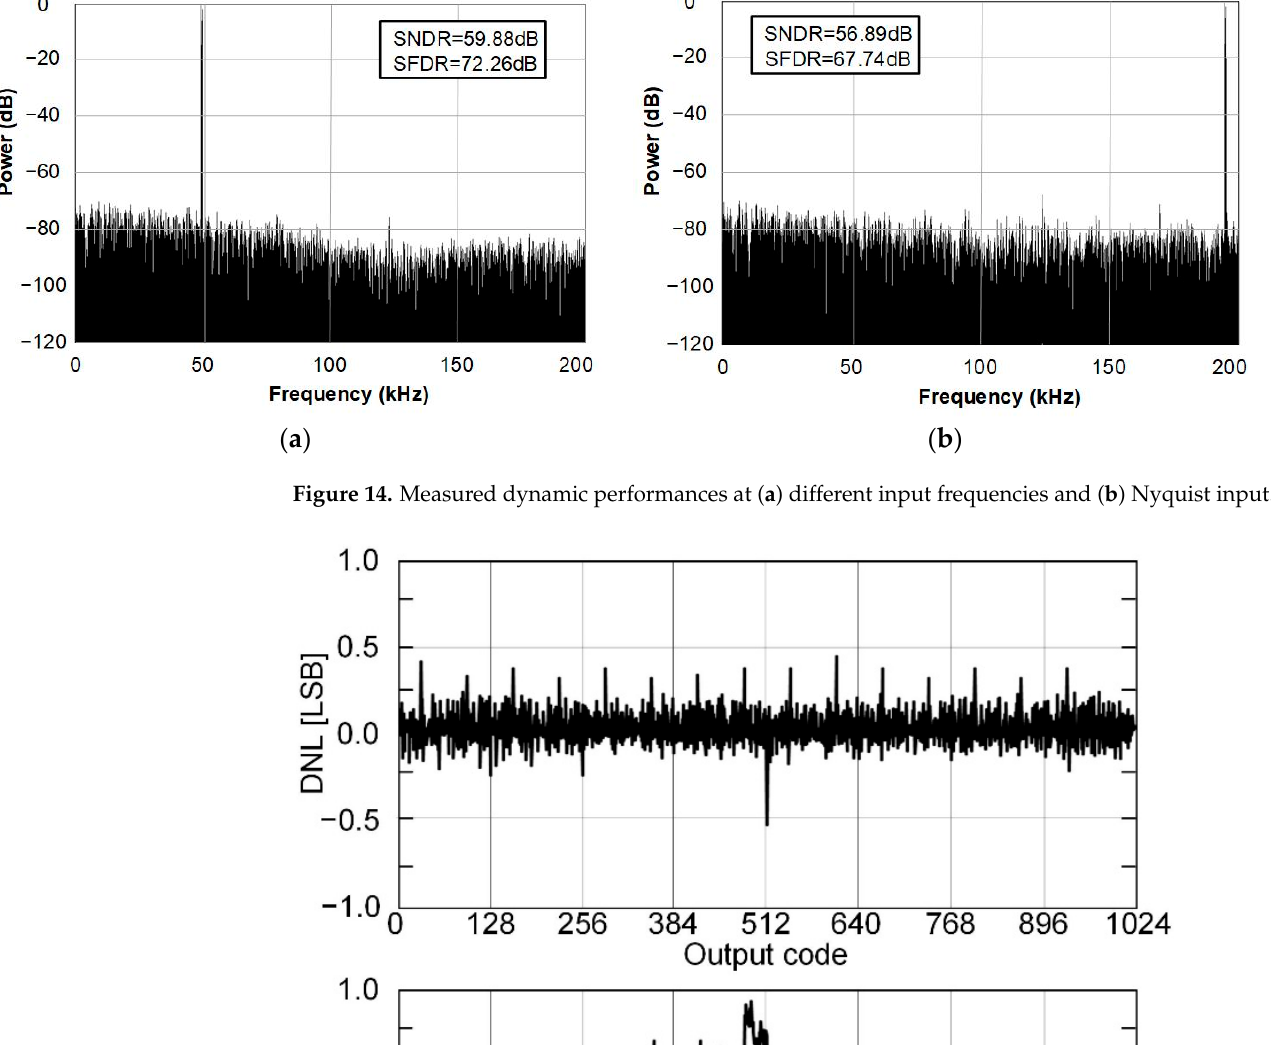
Figure 13. Die microphotograph of proposed SAR ADC.